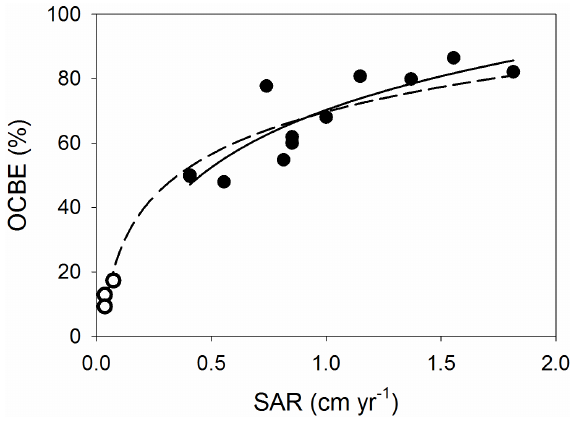
Figure 2. Relationship between OC burial efficiency (OCBE) and sediment accumulation rate (SAR) in Mascarenhas de Moraes. Open circles correspond to sites close to the mar- gins and closed circles correspond to pelagic sites. The dashed line represents the logarithmic regression for all sites: OCBE = 19.0ln(SAR) + 69.7; R 2 = 0.92; p< 0 . 0001; n = 15. The solid line represents the logarithmic regression for pelagic sites only: OCBE = 25.8ln(SAR) + 70.3; R 2 = 0 . 76; p< 0 . 0001; n =